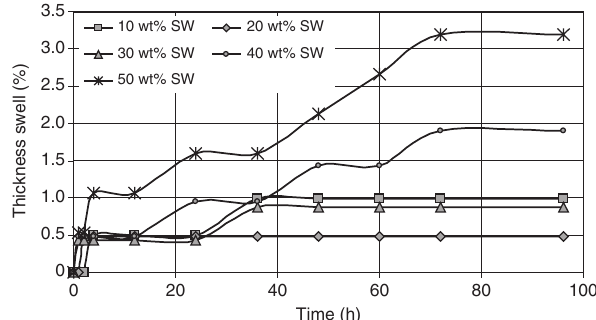
Figure 11 TS as a function of soaking time for different weight percentages of almond shell particle in SW.